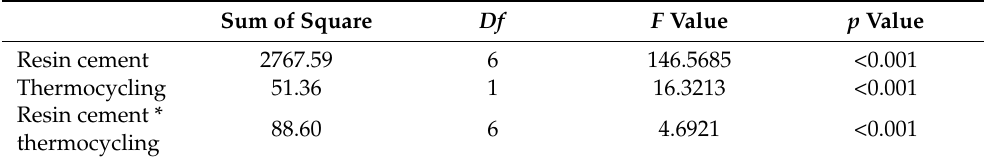
Table 3. Results of the two-way ANOVA carried out for the TBS results between PEEK and each resin cement, both with and without thermocycling.